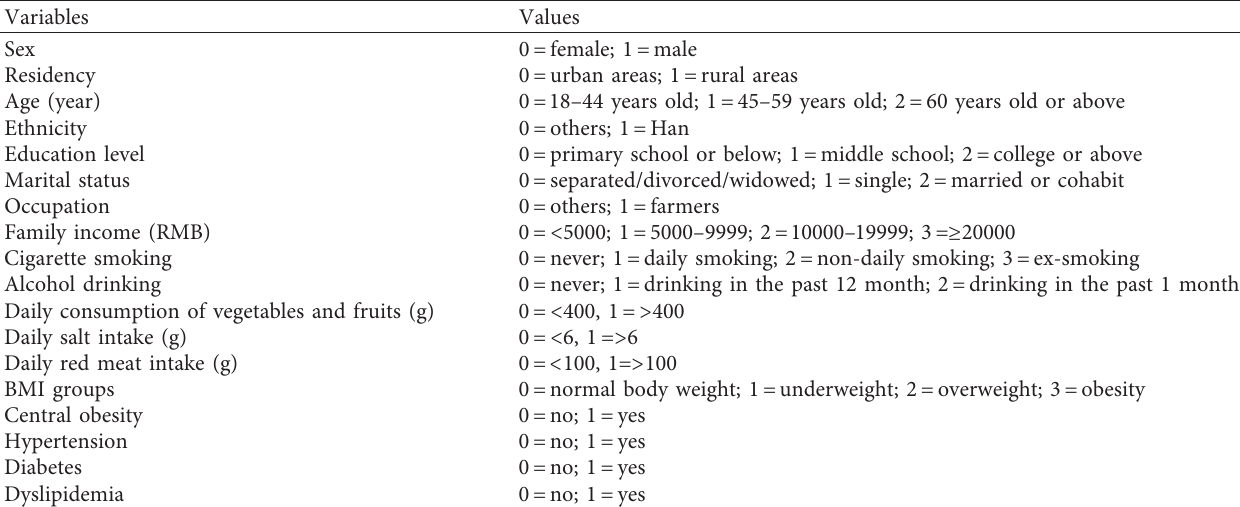
Table 1: Values of variables in multivariate logistic regression model.